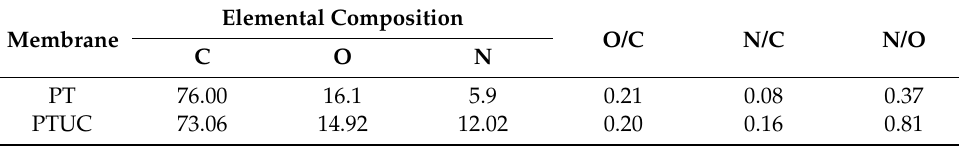
Table 1. Elemental compositions of the membranes.